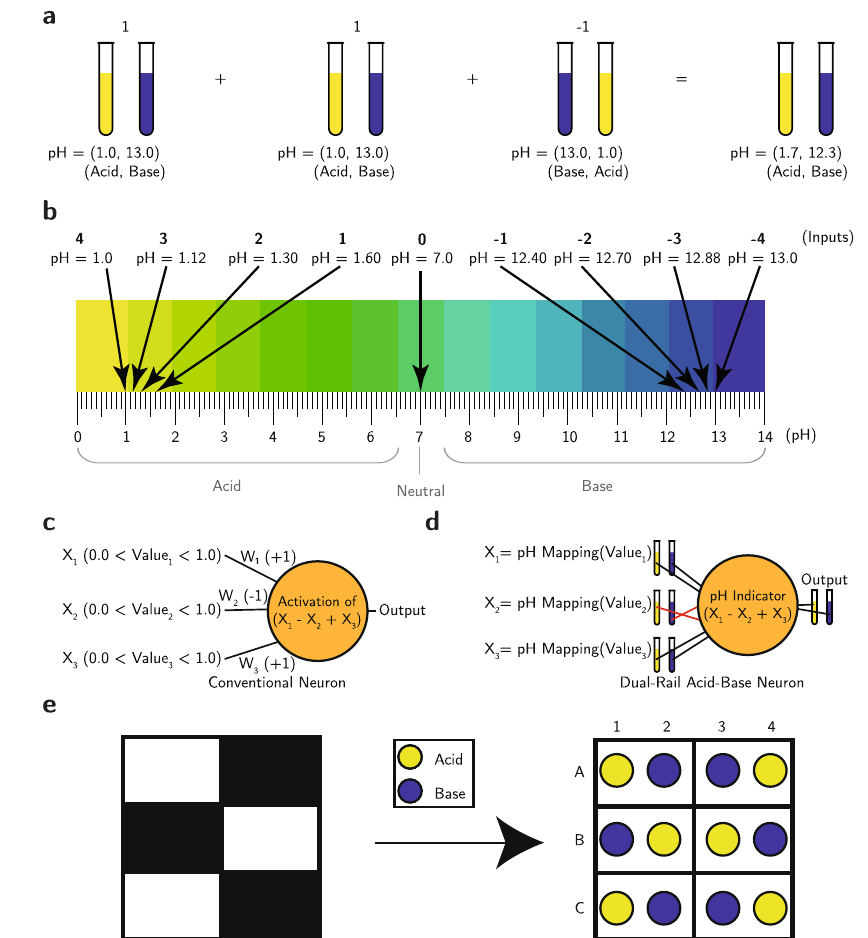
c Conventional neuron with its default operations. d Equivalent neuron using an acid-base encoding with analog input values mapped to the corresponding pH value from the calculated range. Crossing lines indicate multiplying by − 1.